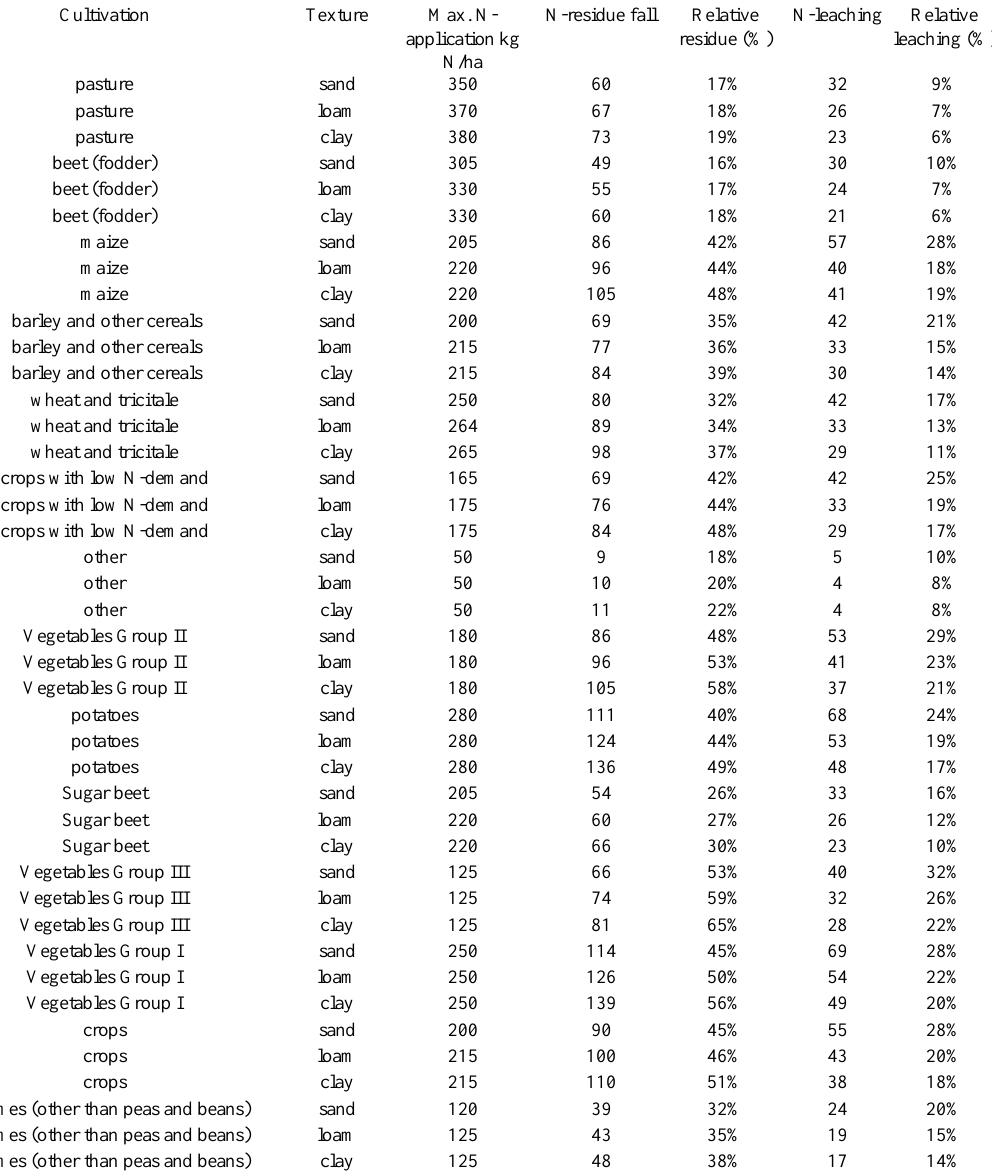
Table A3: parameter values for maximal fertilizer application, fall nitrate residues in soils and winter nitrate leaching in function of cultivation and soil